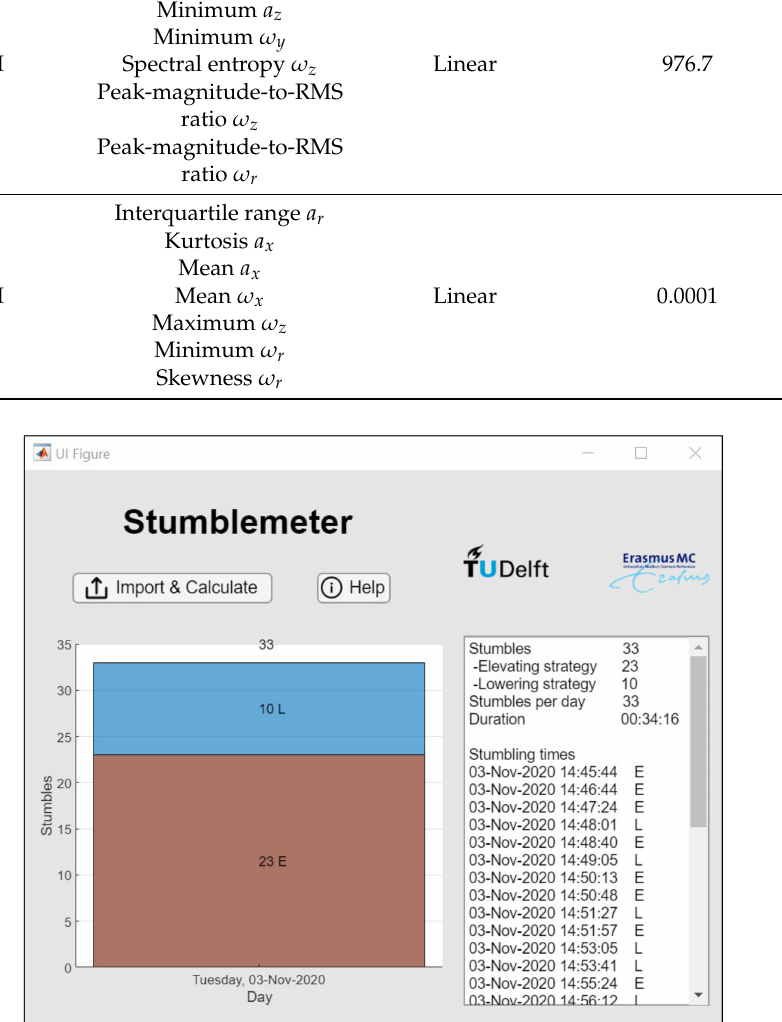
Figure 8. Interface of the Stumblemeter app. The number of stumbles per day is displayed on the left in the form of a histogram. The total number of stumbles, the duration of the measurement, and the individual stumbling times are displayed on the